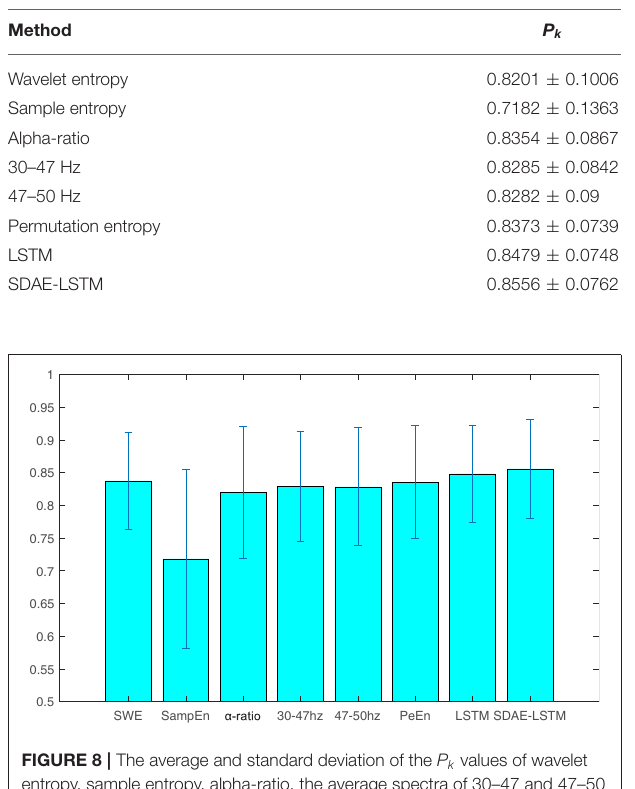
TABLE 1 | P k values of wavelet entropy, sample entropy, alpha-ratio, the average spectra of 30–47 and 47–50 Hz, permutation entropy, LSTM, and SDAE-LSTM.